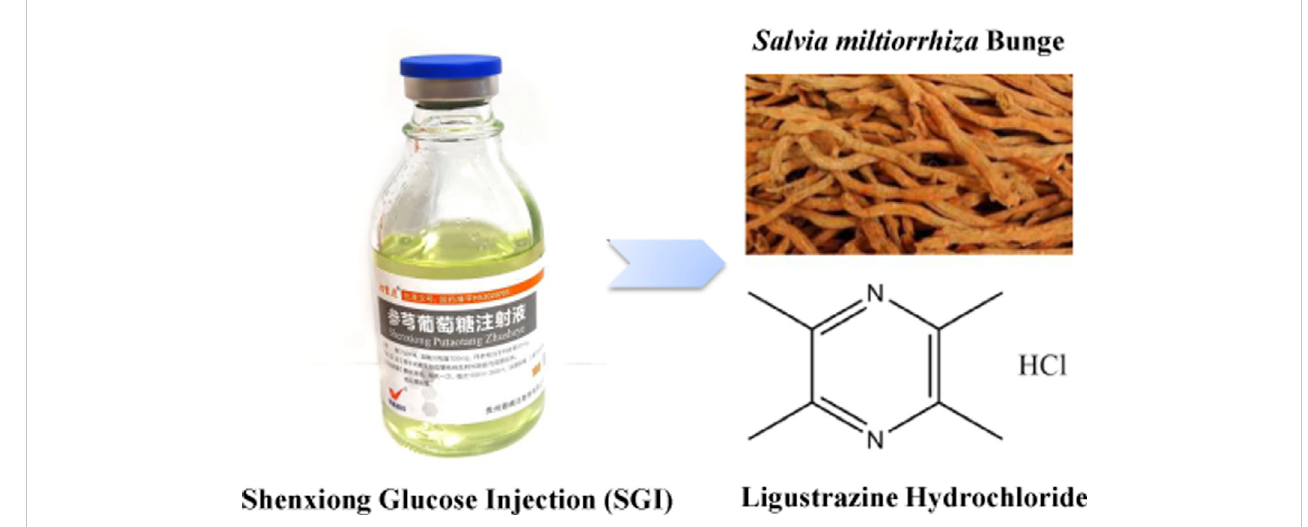
FIGURE 1 SGI and its